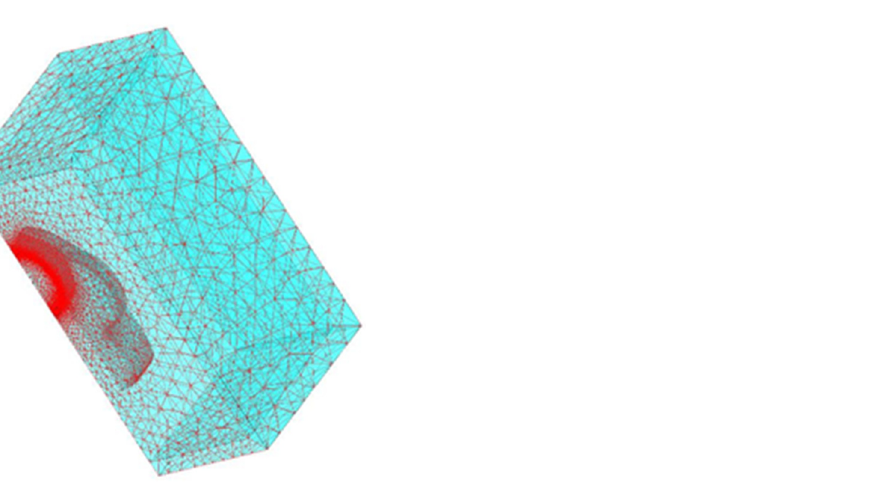
Figure 13. A quarter-pin model in the electromagnetic field of crankshaft N1.